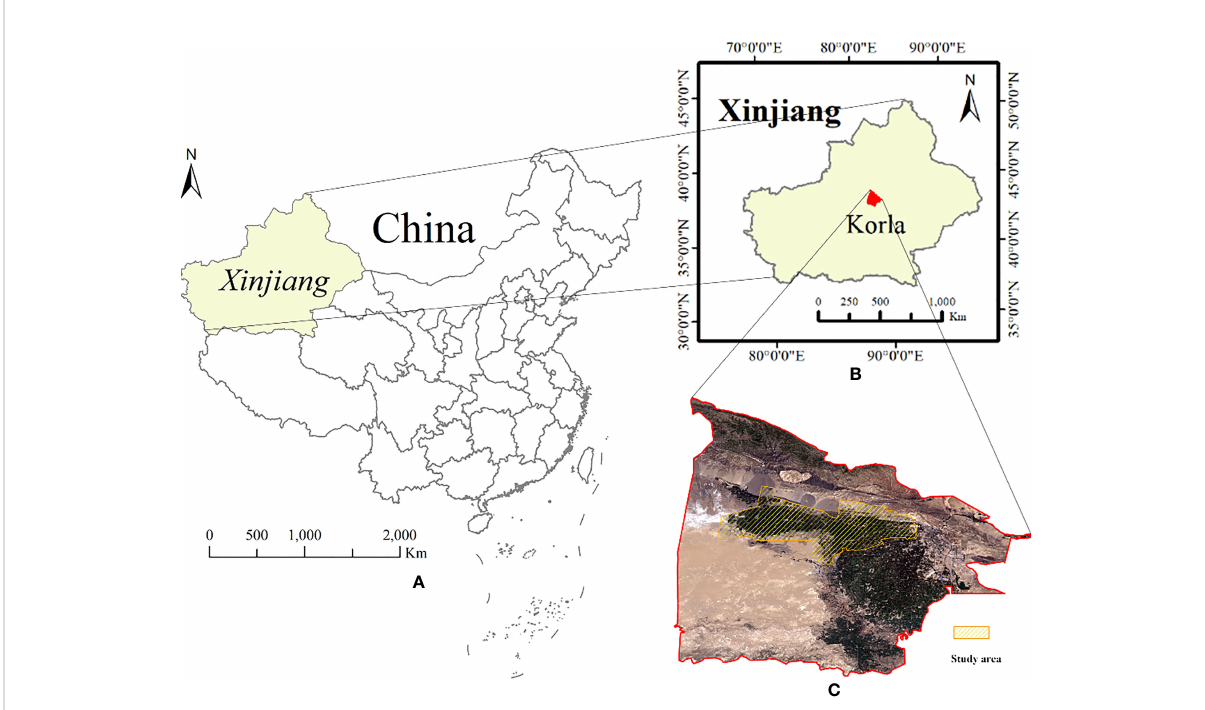
FIGURE 2 Location of the study area and Sentinel-2 imagery. (A) China map, (B) Korla city, Bayingolin Mongolian Autonomous Prefecture, Xinjiang, (C) Sentinel-2 satellite multispectral image of the study area, note, Red: B4 band; Green: B3 band; Blue: B2